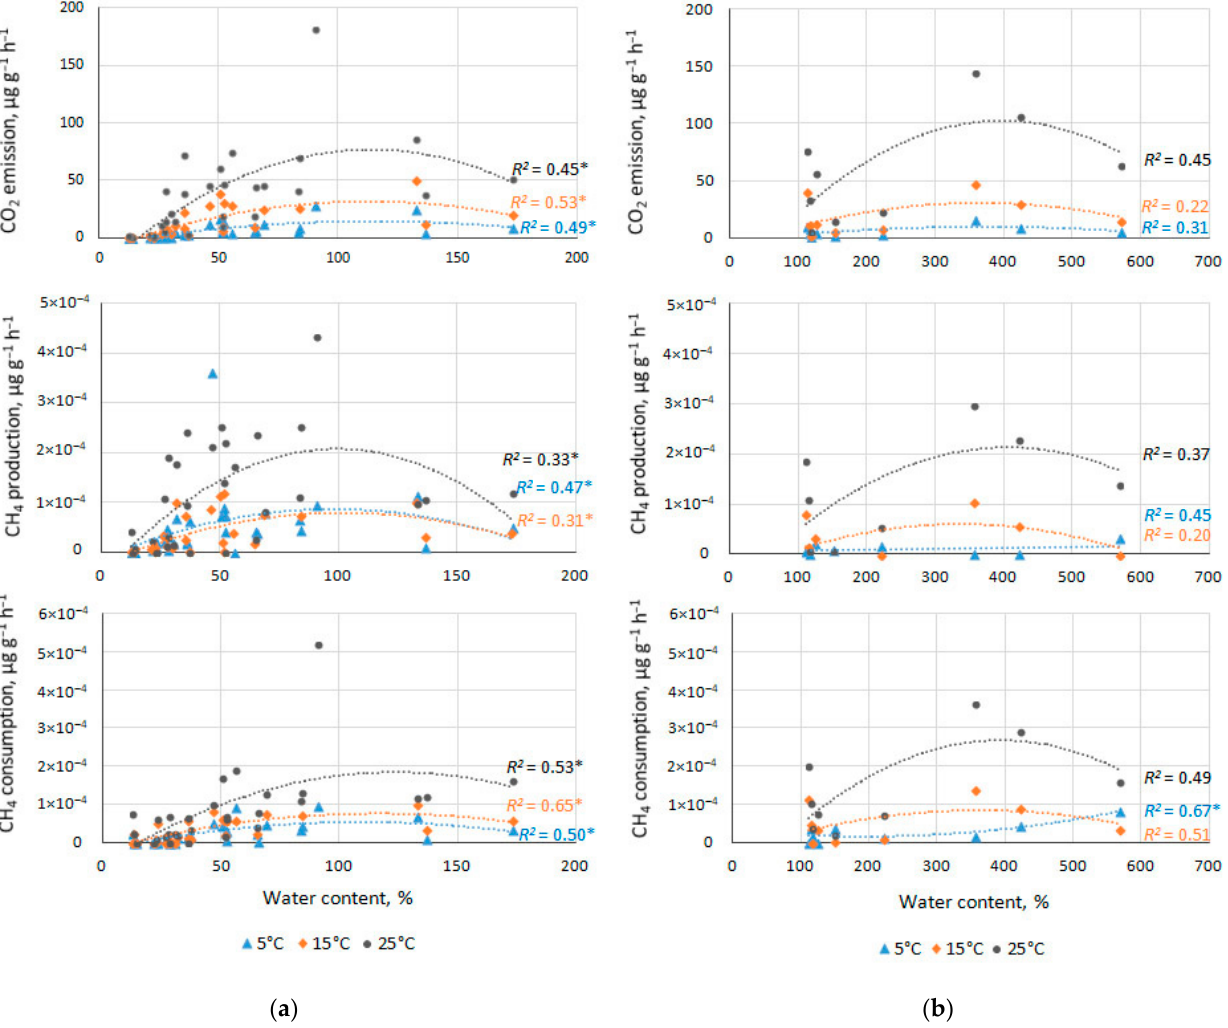
Figure 5. The relationship between CO 2 and CH 4 fluxes and water content of larch ( a ) and birch ( b ) CWD samples at different temperatures. Superscript * indicates significance at p < 0.05.